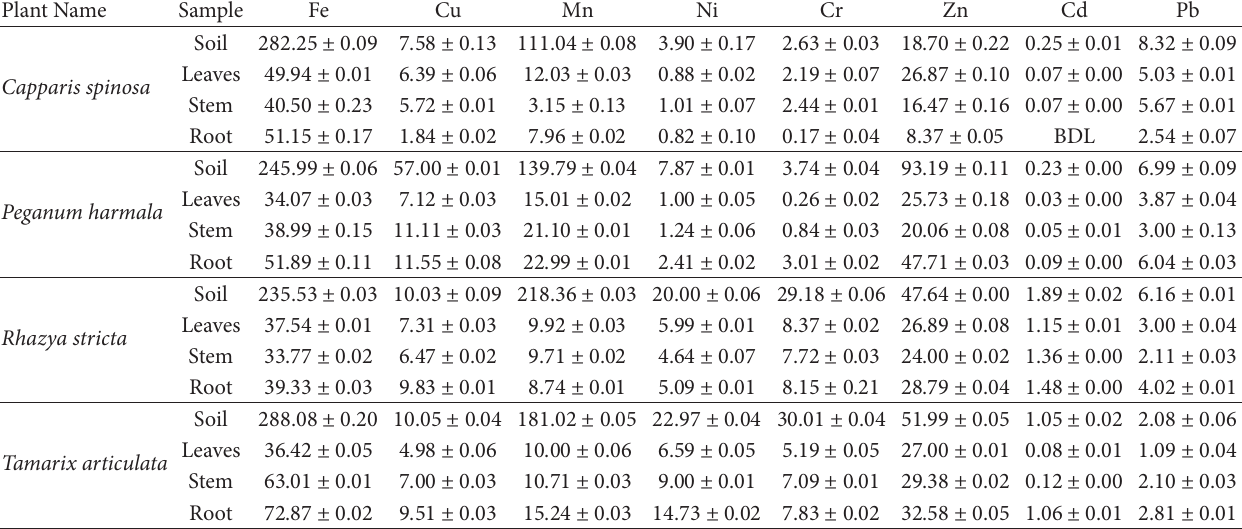
Table 2: Level of heavy metals (mg/kg) in medicinal plants and soil samples of